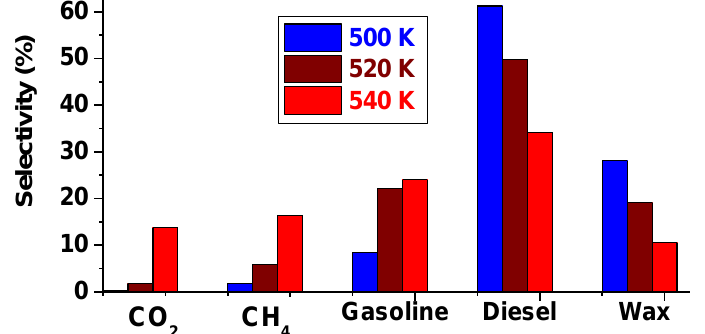
Figure 6. The aggregated product fractions of the Co/C catalyst tested at 500 K, 520 K, and 540 K (pressure = 2 MPa; GHSV = 2000 cm 3 h − 1 g − 1 of the catalyst).